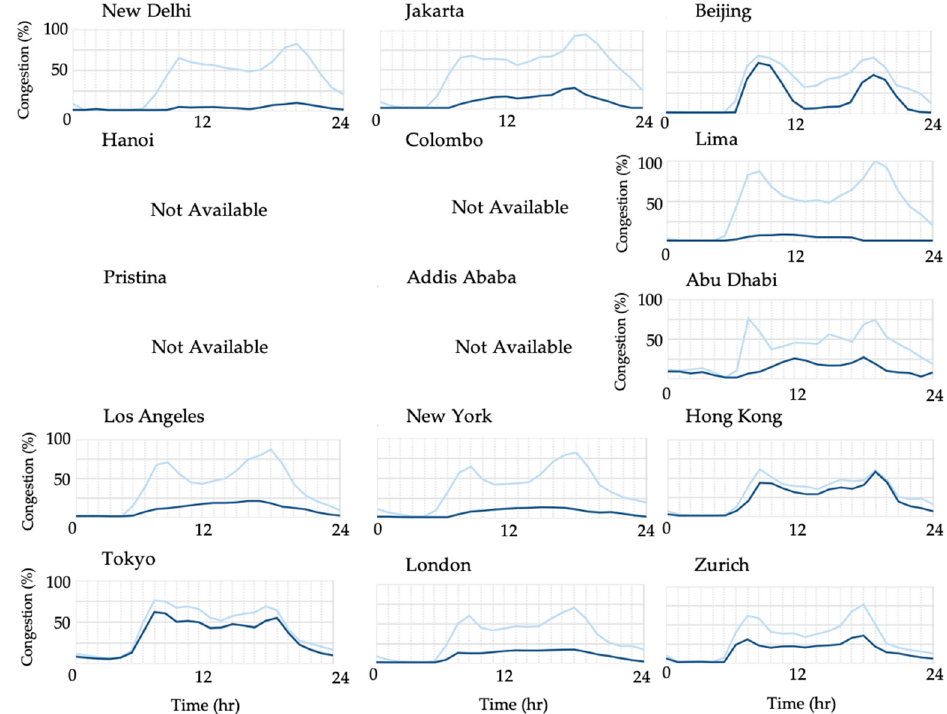
Figure A1. Traffic congestion levels from 15 selected cities.